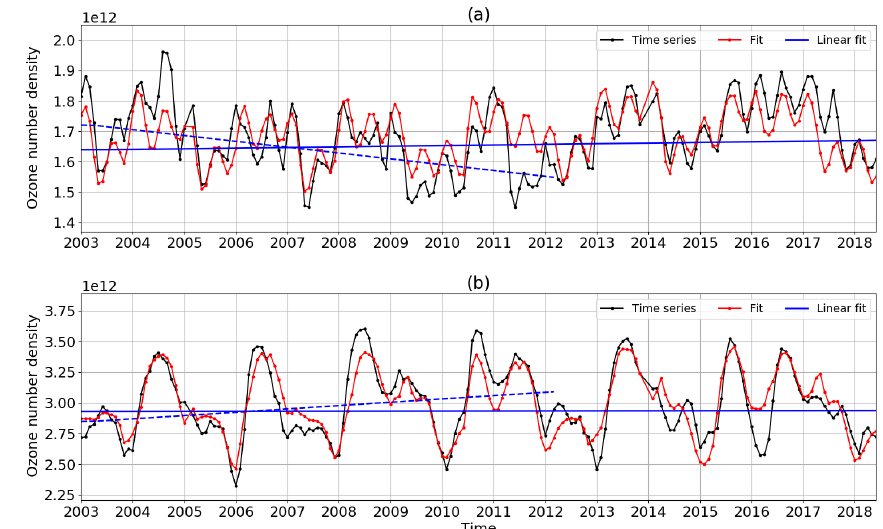
Figure 7. Merged number density (molec . cm − 3 ) time series of SCIAMACHY/OMPS-LP merged ozone (“plain debiased”) from 2003 to 2018 (in black) with MLR fit (in red) and linear trend term superimposed in blue (the dashed lines refer to the SCIAMACHY period until early 2012): in panel (a) at 34.8km and in panel (b) at 21.7km in the tropics, i.e., the [ − 5, 5 ◦ ] latitude bin.